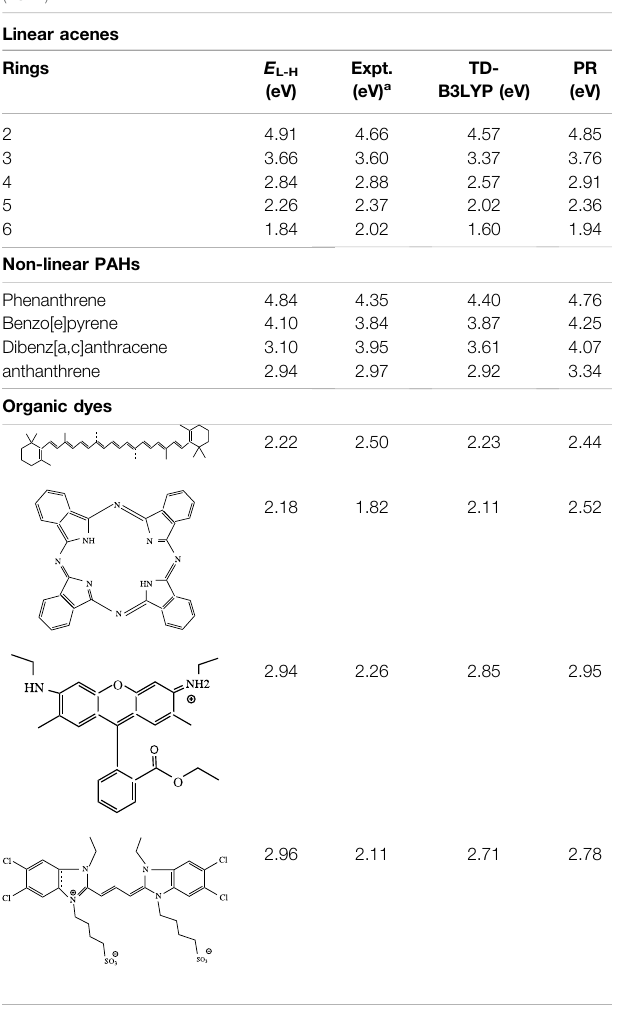
FCT scheme using an RS technique in CIK. As per the description TABLE 15 | HOMO-LUMO gap ( E L-H ), HOMO-LUMO singlet excitation energy in